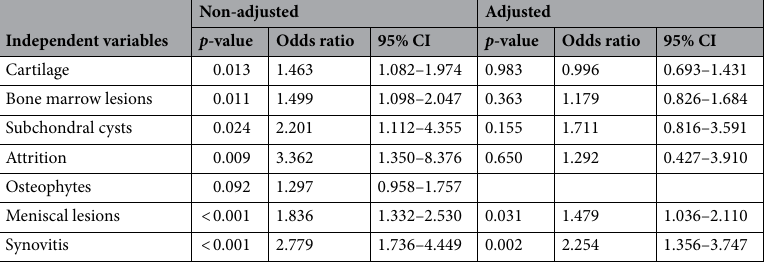
Table 4. MRI lesion related to the presence of early knee osteoarthritis. Logistic regression analysis was performed on knees with Kellgren–Lawrence grade 0 or 1 in radiographs. In non-adjusted model, dependent variables was the presence of early KOA; the independent variables were each MRI lesion. In adjusted model, dependent variables was the presence of early KOA; the independent variables were age, BMI, MRI lesions except osteophytes.